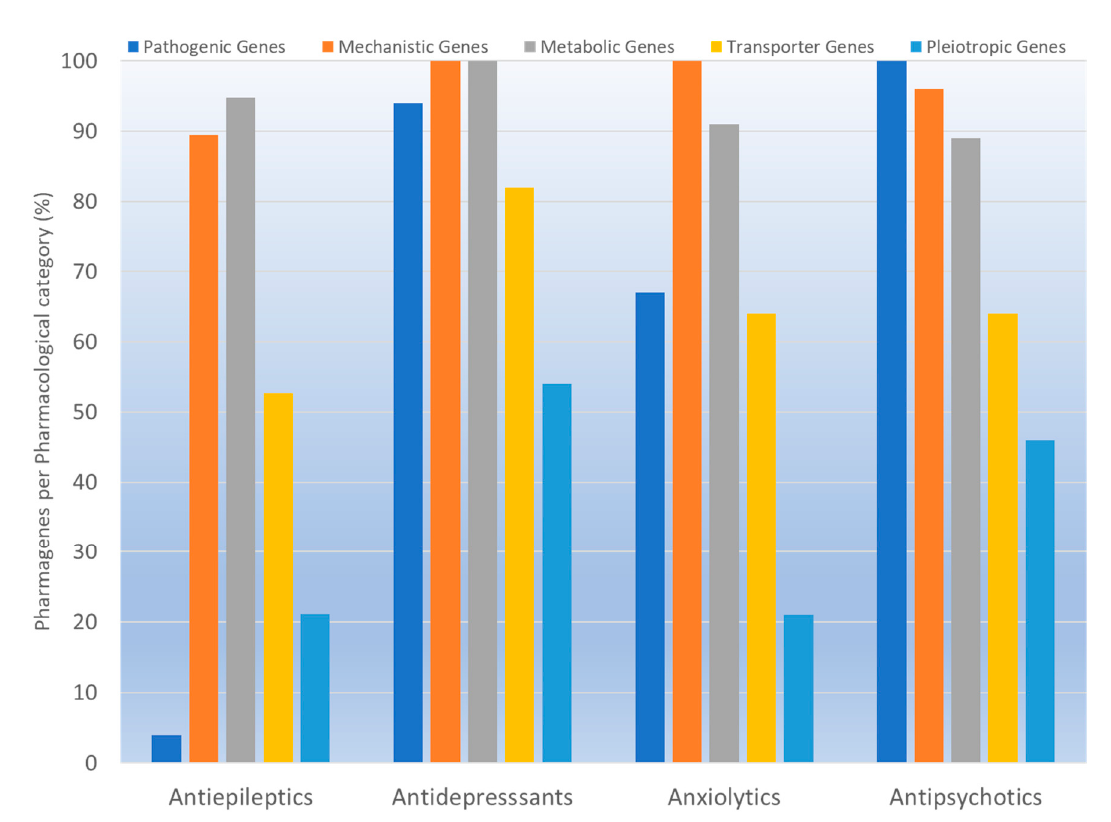
Figure 1. Pharmacogenetic machinery-related pathogenic, mechanistic, metabolic, transporter, and pleiotropic genes of antiepileptics, antidepressants, anxiolytics, and antipsychotics.